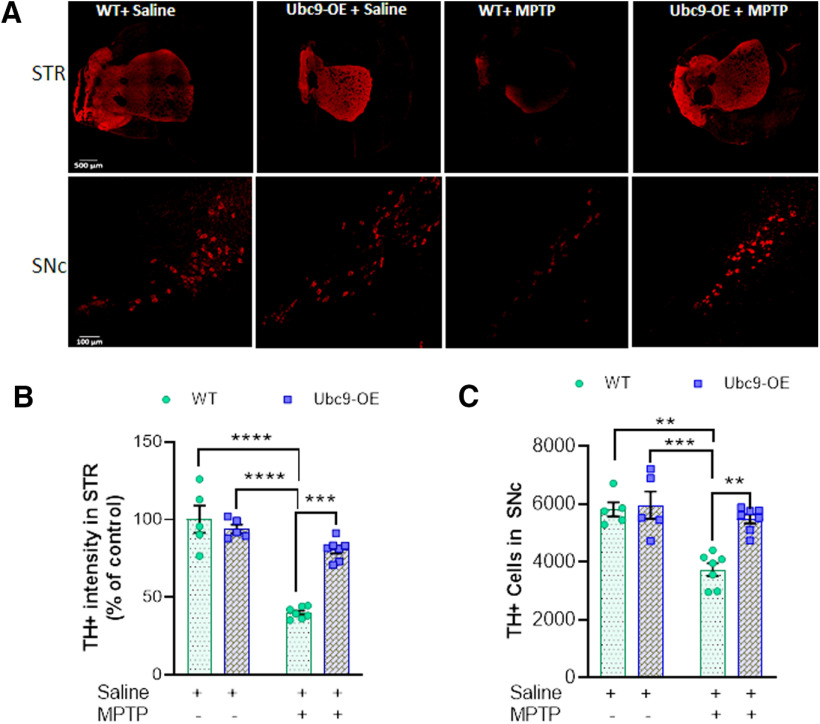
The overexpression of Ubc9 protects dopaminergic neurons from MPTP-induced toxicity in mouse brain. A, Confocal images of the striatum (STR) and SNc region of C57Bl/6 mice after staining with anti-TH antibody (1:100) conjugated to Alexa Fluor 555 (1:250). B, Quantitative analysis of TH+ nigrostriatal projection intensity in the striatum of mouse brains. Dopaminergic projections in the STR of Ubc9-overexpressing Tg mice (n = 7) are significantly protected against MPTP toxicity, compared with WT-MPTP (n = 7). C, The number of TH+ neurons in the SNc was significantly higher in Ubc9-Tg mice (n = 7) than that in WT siblings (n = 7), after chronic MPTP treatment. Dots represent values from individual mouse and horizontal bars represent mean ± SEM. Statistical analysis was applied using two-way ANOVA, Tukey’s test; **p < 0.01, ***p < 0.001, ****p < 0.0001; size bars (500 μm for STR and 100 μm for SNc).